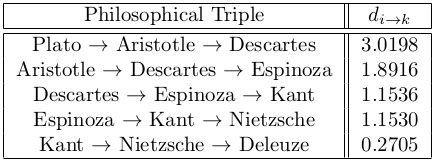
Table from the paper: Can the evolution of music be analyzed in a quantitative manner?
Table text:
PhilosophicalTriple
d i → k
Plato → Aristotle → Descartes
3.0198
Aristotle → Descartes → Espinoza
1.8916
Descartes → Espinoza → Kant
1.1536
Espinoza → Kant → Nietzsche
1.1530
Kant → Nietzsche → Deleuze
0.2705